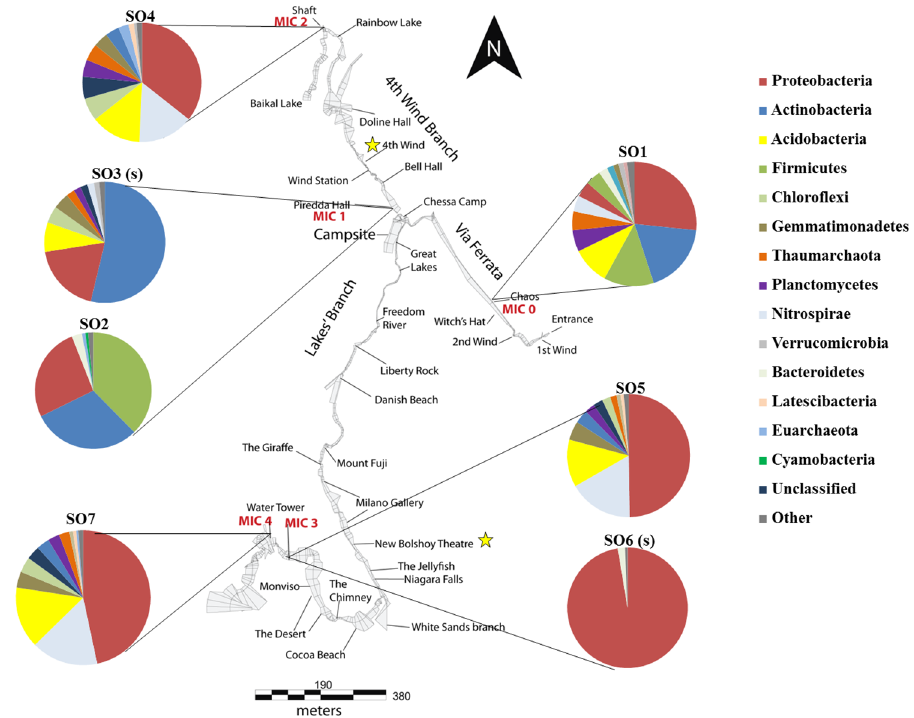
Fig 2. Phyla distribution at different sampling points. Illustrated are the bacterialphyla and proteobacterial classes found within the cave. Taxonomic classificationwas performed accordingto SILVA SSU rRNA database123. Bacterial phyla with a relative abundance lower 0.5% were summarized in the artificial group “Other”. This group includesrepresentatives of the followingphyla: Deinococcus-Thermus, JL-ETNP-Z39, Chlorobi, Saccharibacteria, SHA-109, TM6, Armatimonadetes, Chlamydia, Elusimicrobia, WD272, Candidate_division_OP3, Parcubacteria, Fibrobacteres, Fusobacteria, OC31, TA06, WCHB1-60, Aenigmarchaeota, Spirochaetae, Thermotogae, Lentisphaerae, Synergistetes, Candidate_divison_SR1, SM2F11, and Omnitrophica. Two yellow stars indicate representative samplinglocationsfor the chemical analysisof the 4 th Wind branchand the Lakes